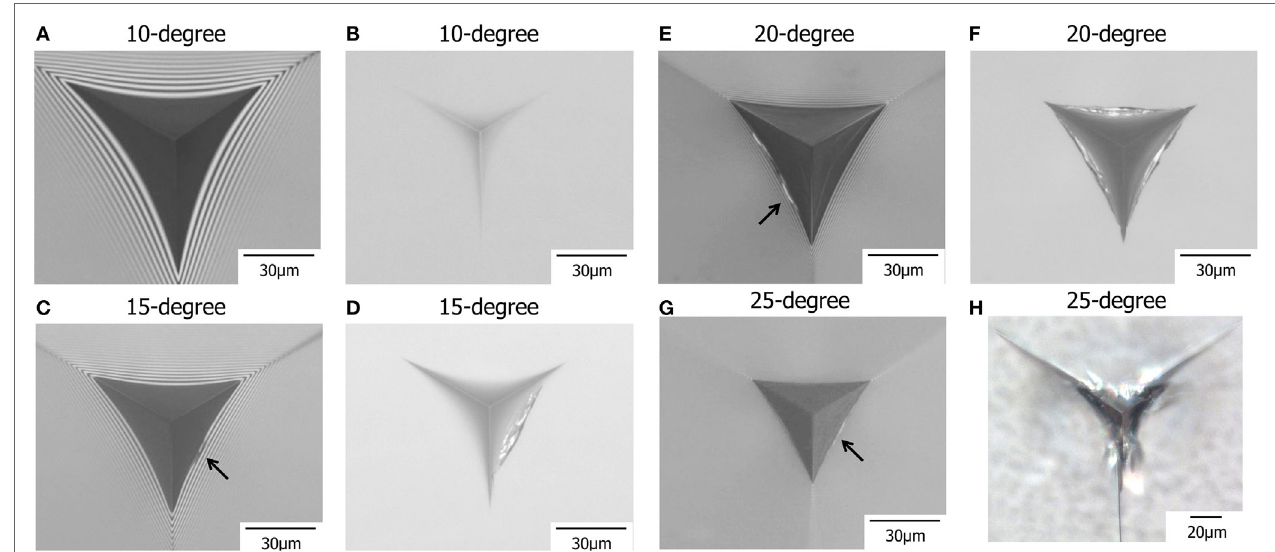
FigUre 9 | Photos of contact regions under load and residual imprints after unload . The maximum indentation load is 10 N. (a) Under a load of 10 N (a maximum load) and (B) after unload for 10° indenter. (c) Under a load of 5.8 N during unloading and (D) after unload for 15° indenter. (e) Under a load of 9.2 N during unloading and (F) after unload for 20° indenter. (g) Under a load of 6.1 N during loading and (h) after unload for 25° indenter. The arrows in (c,e,g) indicate the positions of initial edge cracks observed during loading or